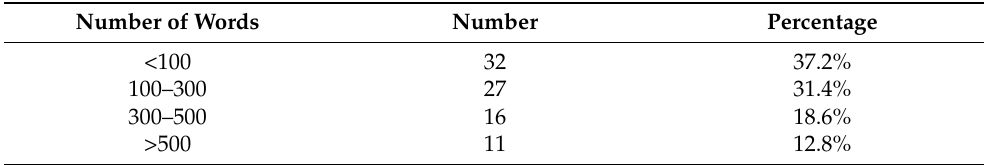
Table 2. The number of words used in each submission.